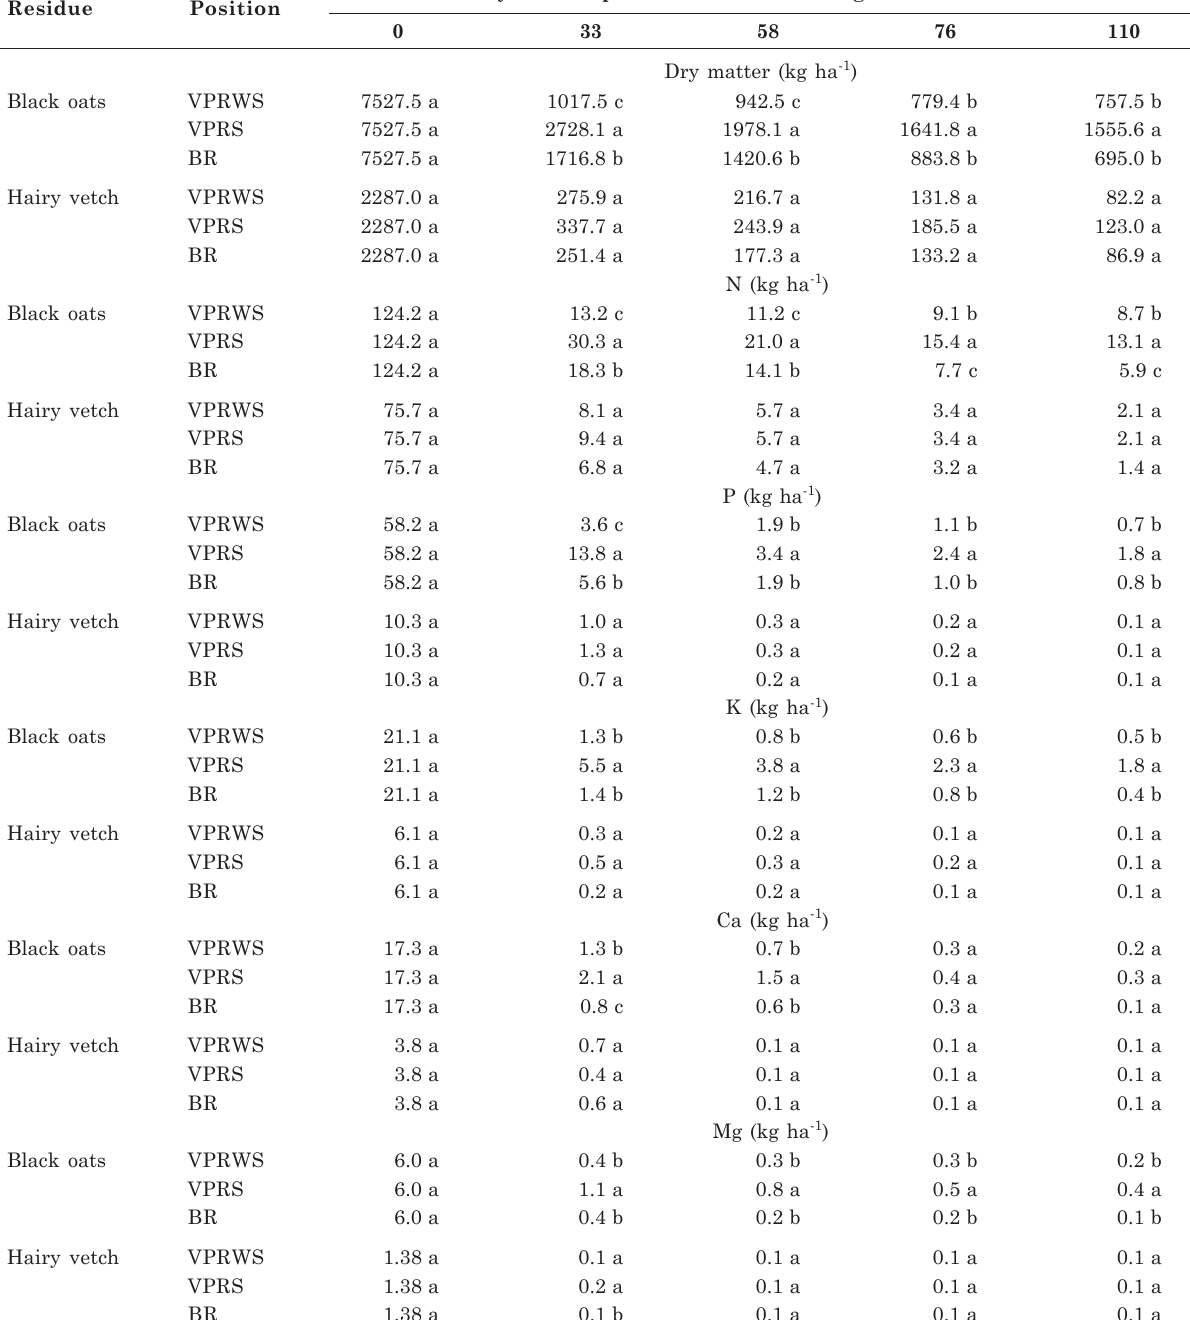
Table 2. Quantity of dry matter, N, P, K, Ca and Mg in black oat and hairy vetch residues collected at different times in the vine plant row without plastic shelter (VPRWS), in the vine plant row with